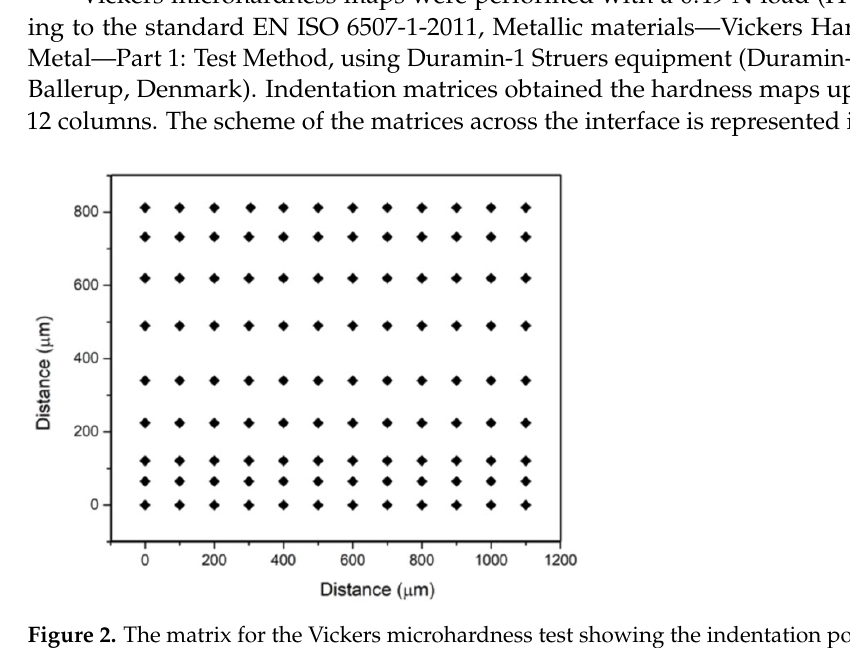
Figure 2. The matrix for the Vickers microhardness test showing the indentation position (